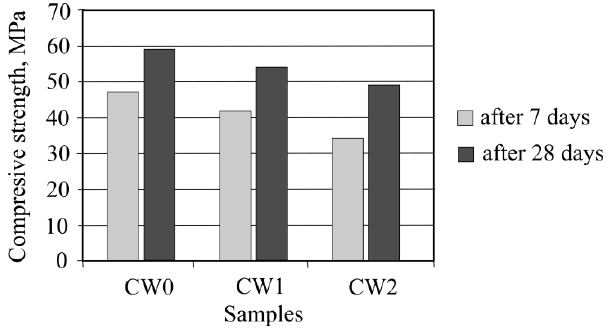
Figure 12. Dependence of samples’ compressive strength on the amount of concrete waste.